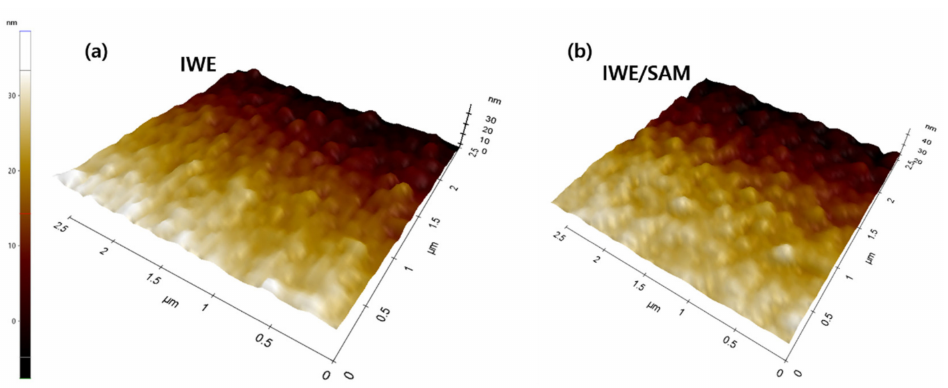
Figure 2. AFM results of ( a ) bare IWE; ( b ) IWE with the modification of SAM on the surface (IWE/SAM).